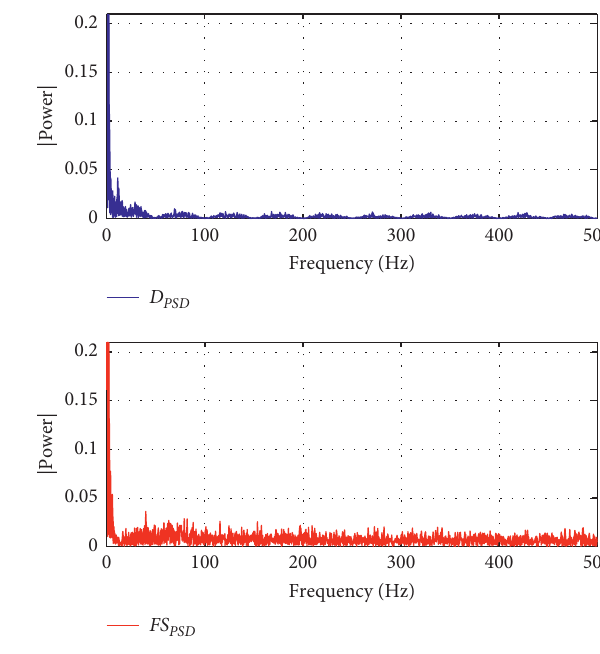
Figure 11: Power spectrum density.